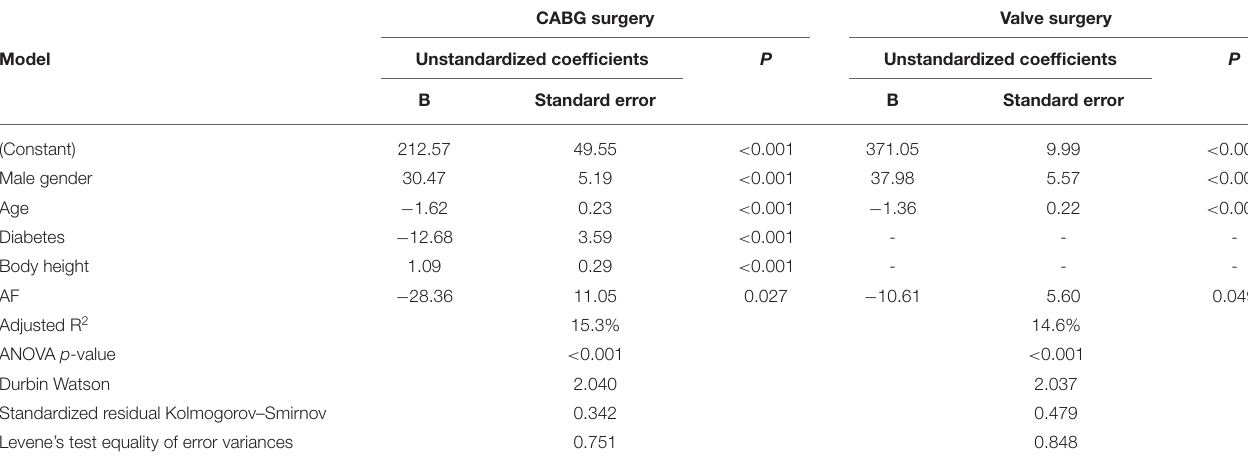
TABLE 2 | Multivariable linear regression model of 6-MWD post cardiac surgery.